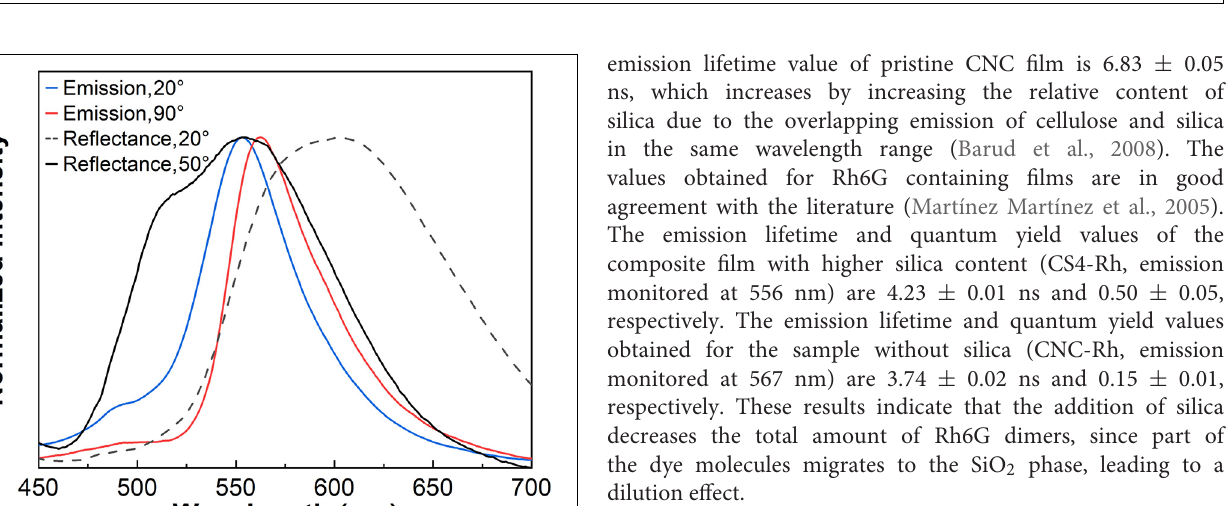
FIGURE 7 | Chromaticity diagram of reflection of the CS4-Rh composite film as a function of the detection angle (0 ◦ < θ < 60 circ , A ). Chromaticity diagram of the emission of CS4-Rh composite film under excitation at 348 nm as a function of the detection angle (0 ◦ < θ < 90 ◦ , B ).